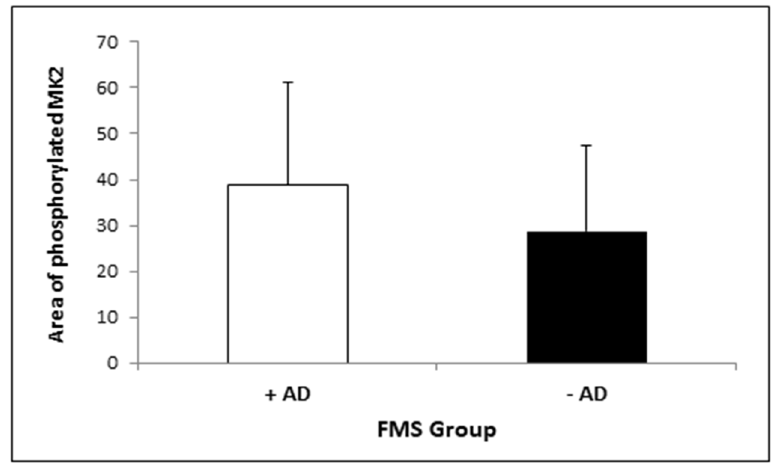
Figure 4. Area of phosphorylated MK2 in peripheral blood monocytes of FMS patients with antidepressant (+AD) and without antidepressant (−AD) intake. (Data are presented in Mean (SD); Student’s t -test: p = 0.094).